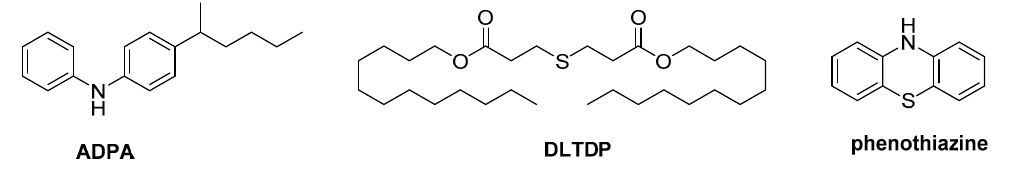
Figure 1. Some representative antioxidants.